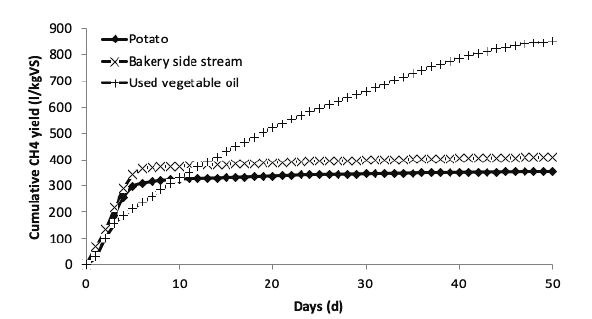
Figure 5: 50-day cumulative CH4-production curves of food proces- sing side